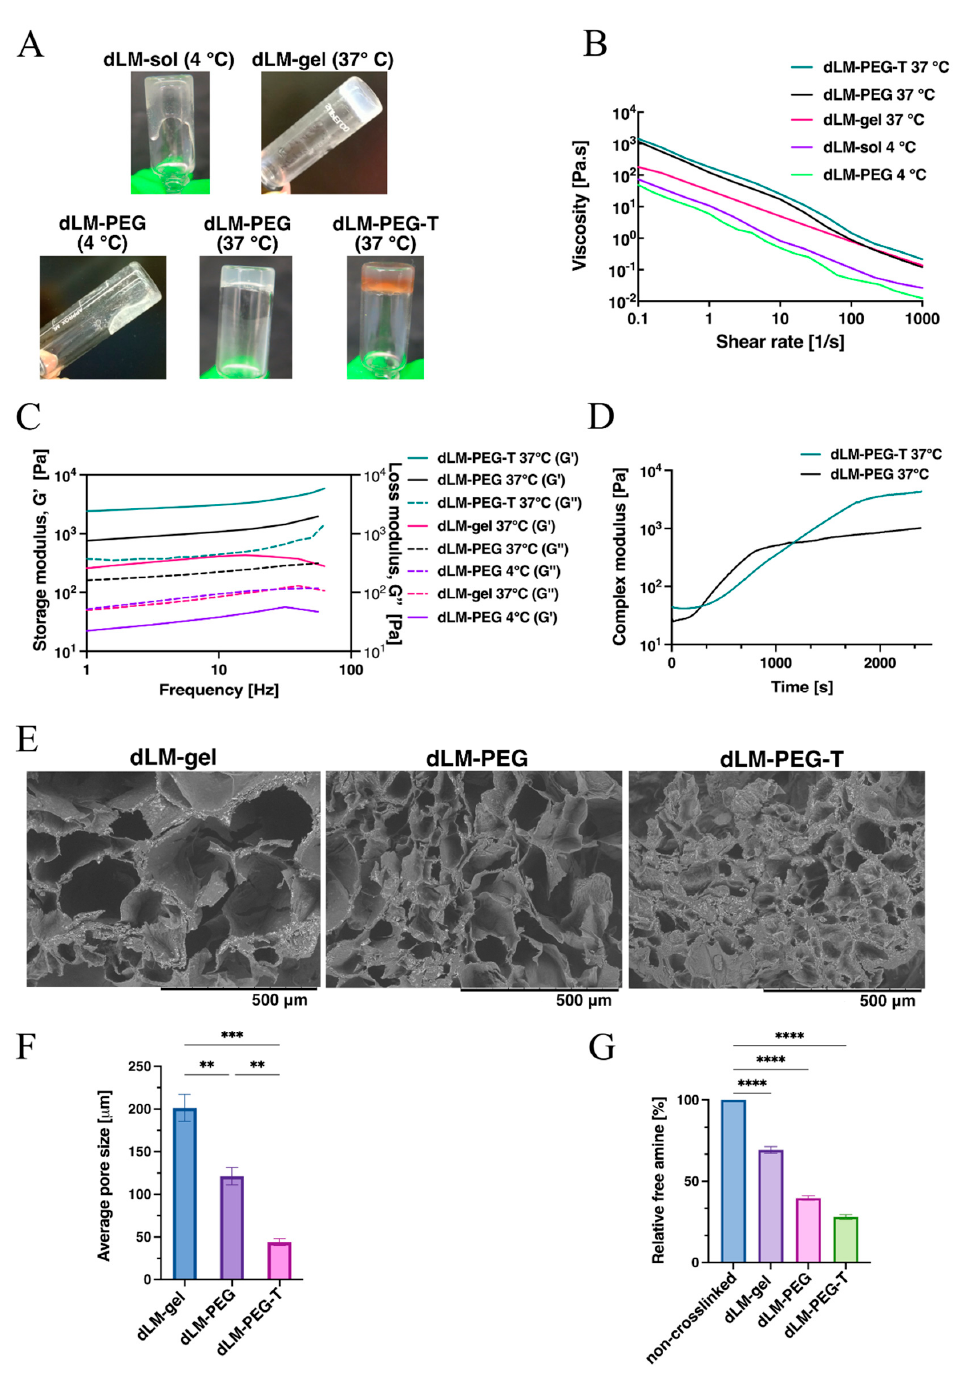
Figure 2. Investigation of dLM formulations ( A ) visually with tube inversion behavior of dLM-sol (4 ◦ C), dLM-gel (37 ◦ C), dLM-PEG (4 ◦ C), dLM-PEG (37 ◦ C), and dLM-PEG-T (37 ◦ C) followed by ( B ) their viscosity analysis with increasing shear rate. ( C ) Oscillatory frequency sweep at 1% strain to compare storage and loss modulus and ( D ) gelation kinetics of dLM-PEG and dLM-PEG-T at 37 ◦ C. ( E ) SEM images of the cross-section of crosslinked formulations of dLM-gel, dLM-PEG and dLM-PEG-T (scale bar 500 μ m) and their ( F ) average pore size ( n = 3, ** p < 0.01 and *** p < 0.001). ( G ) TNBS assay with relative free amine percentage across all crosslinked formulations relative to non-crosslinked formulations ( n = 3, **** p < 0.0001). Error bars represent the standard error of the mean.